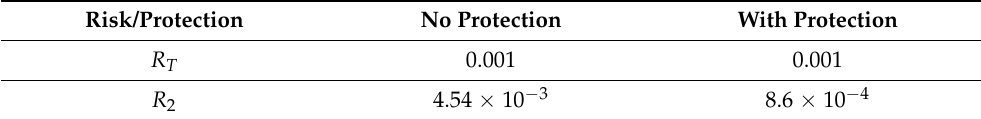
Table 5. Risk R 2 —loss of public service.